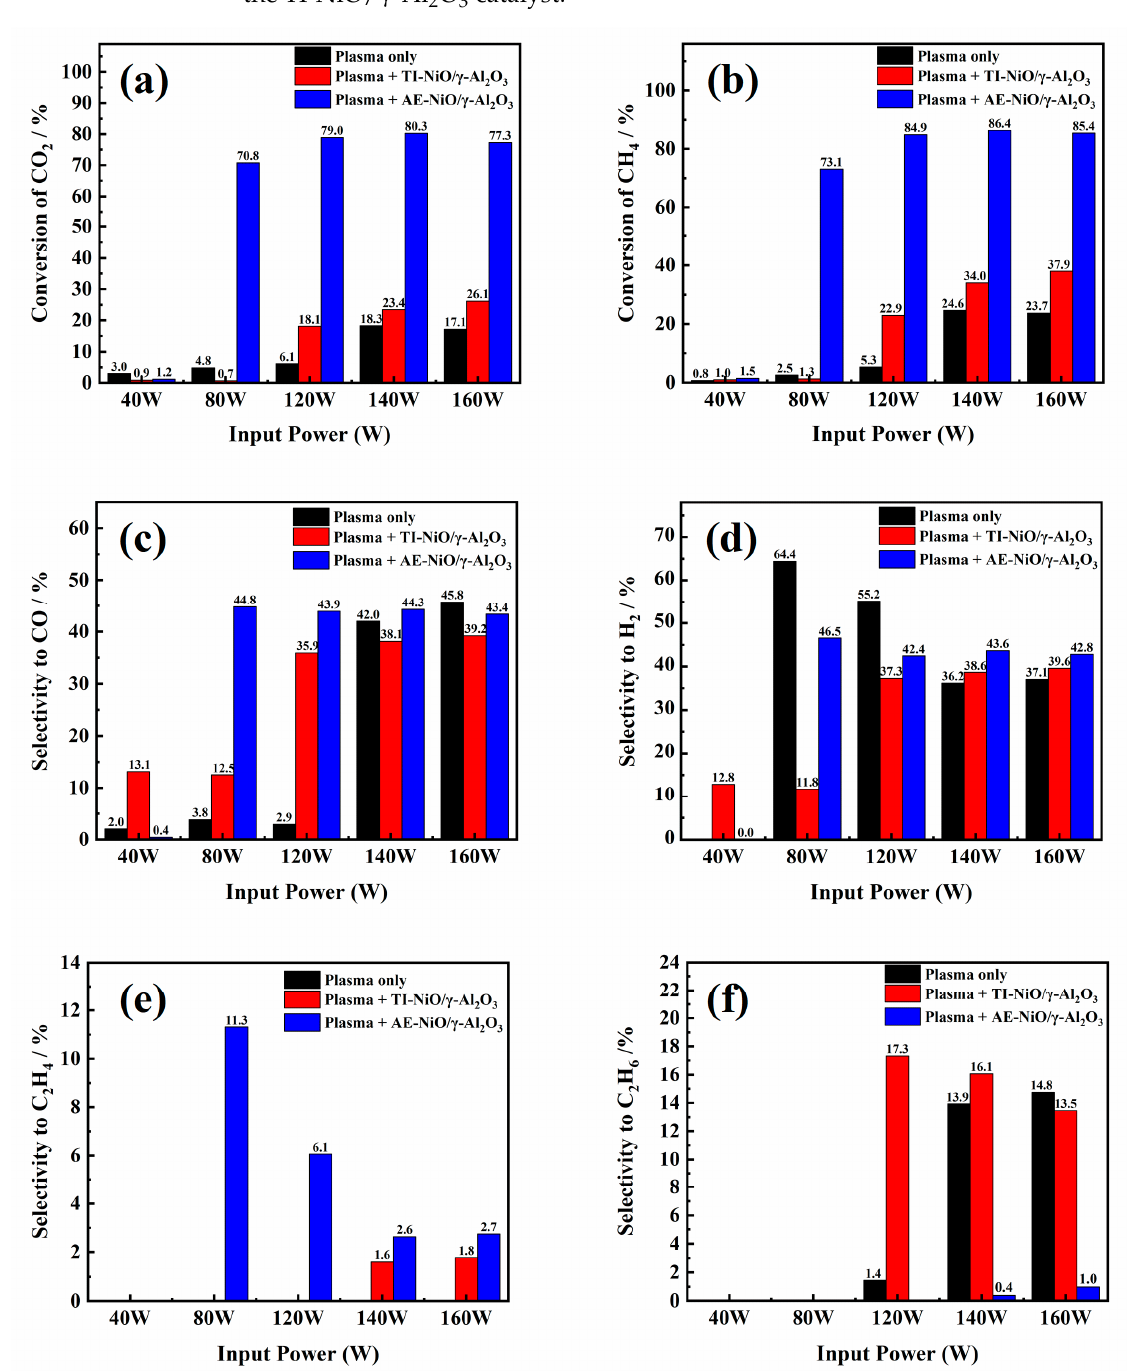
Figure 1. Effect of different reaction modes on the performance of the dry reforming reaction by plasma promoted: ( a ) conversion of CO 2 , ( b ) conversion of CH 4 , ( c ) selectivity to CO, ( d ) selectivity to H 2 , ( e ) selectivity to C 2 H 4 , ( f ) selectivity to C 2 H 6 (CO 2 /CH 4 = 1:1, total feed flow rate 20 mL/min, 600 mg catalyst, room temperature and ambient